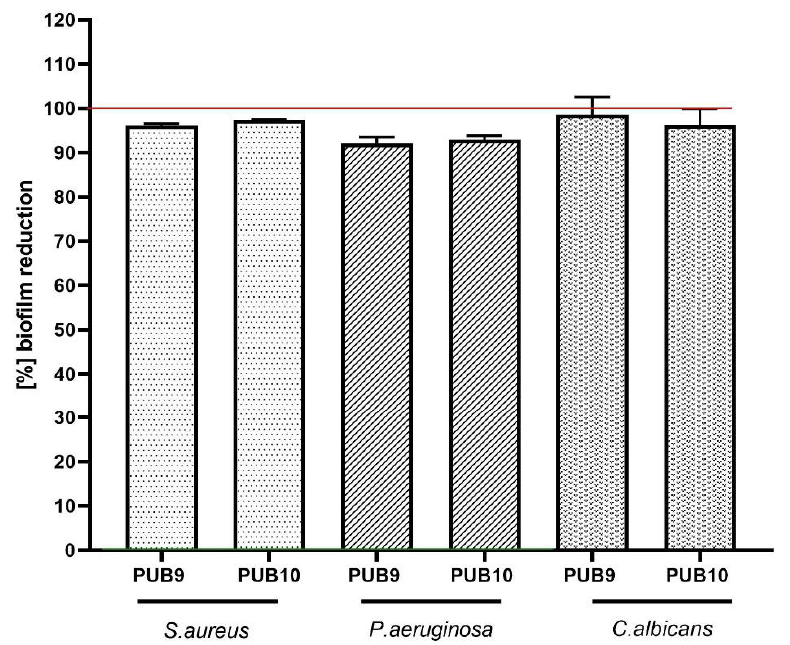
Figure 3. The [%] biofilm reduction of S. aureus 6538, P. aeruginosa 15,442 and C. albicans 103,231 displayed by PUB9 and PUB10 compounds at specific concentrations tested in microplate model. The red line shows level of 100% reduction while no reduction (0%, positive control of growth)